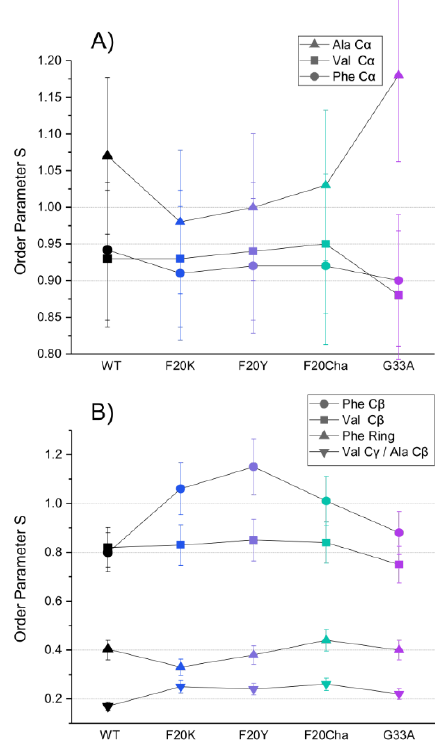
Figure 5. DIPSHIFT derived 13 C– 1 H order parameters for the labeled 13 C atoms of Val 18 , Phe 19 and Ala 21 in amyloid fibrils of the A β 40 peptide variants as representation of the segmental molecular dynamics. ( A ) backbone sites, ( B ) side chains. Error bars were estimated as ±10% of the order parameter value. The order parameters for the Val 18 C β and Ala 21 C β could not be resolved.